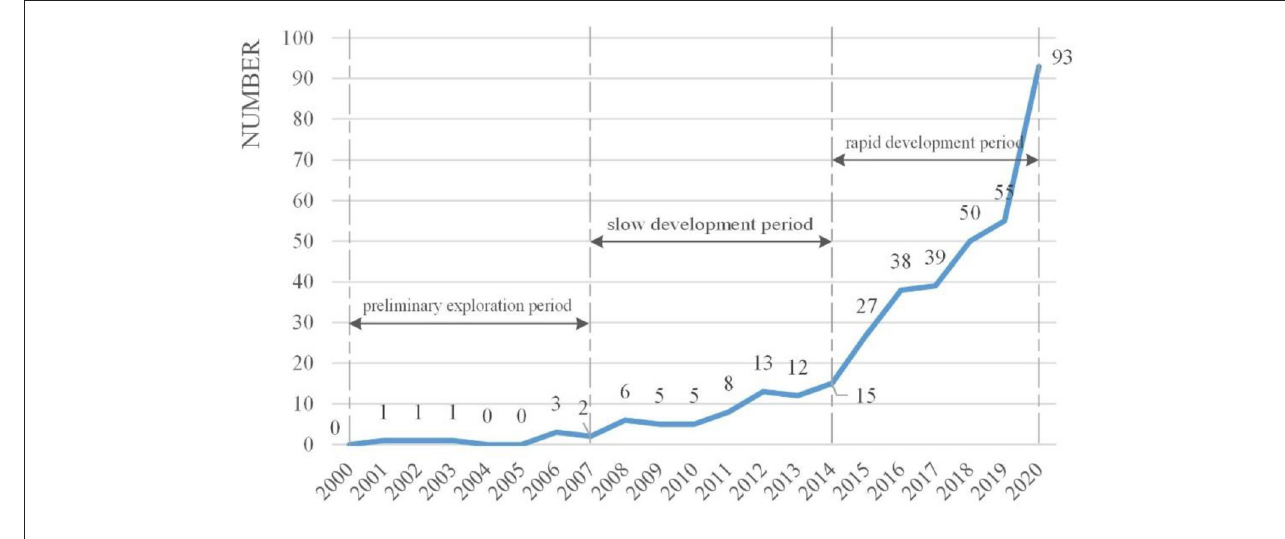
FIGURE 2 | Number of articles on